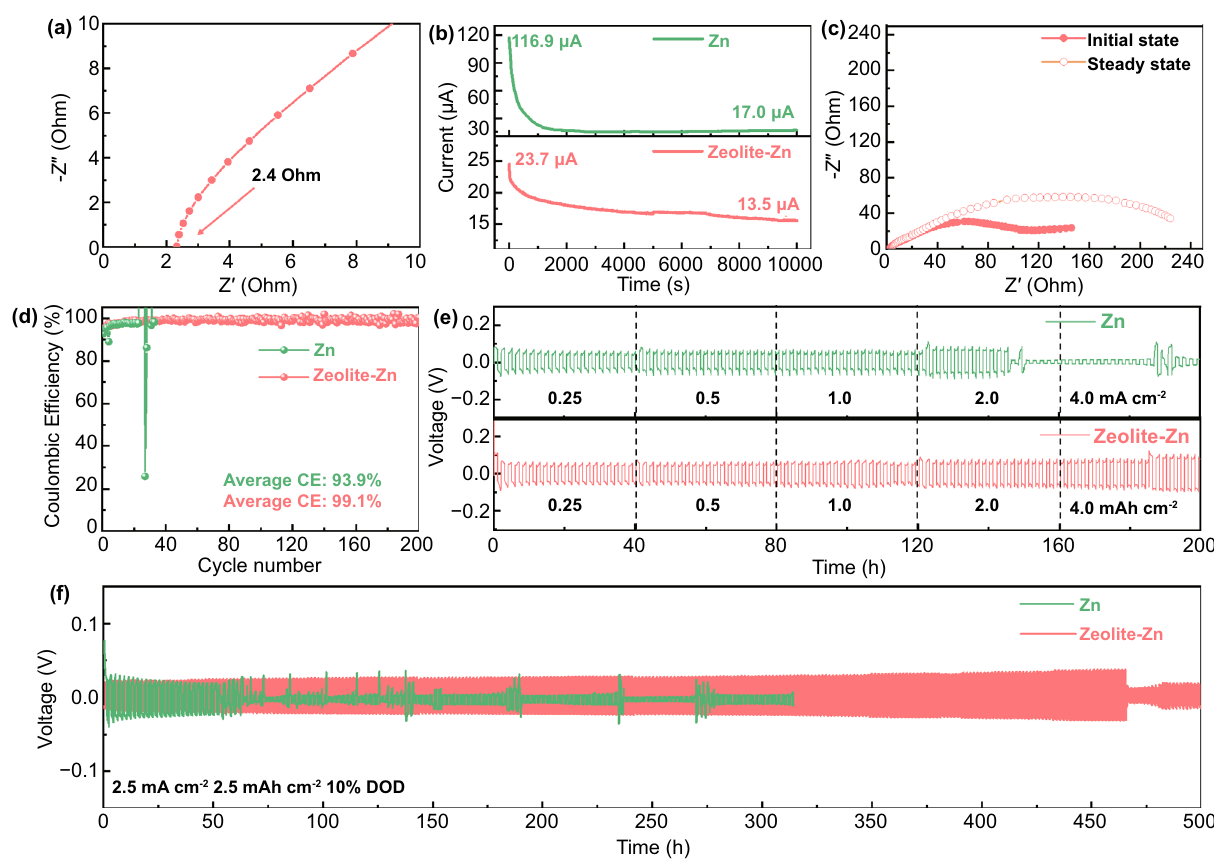
Fig. 2 a EIS plot of the zeolite layer. b Current–time (I-t) curves of a Zn||Zn and Zeolite-Zn||Zeolite-Zn symmetric cells stimulated by a con- stant polarization voltage of 10 mV. c EIS plot of the symmetric cells before (initial state) and after applying voltage polarization for 10,000 s (steady state). d Coulombic efficiencies (CEs) of a bare Zn||Cu and a Zeolite-Zn||Zeolite-Cu asymmetric cells in 1 M ZnSO 4 electrolyte; the employed current density is 0.5 mA cm −2 with a striping upper-limit voltage of 0.5 V. e–f Voltage profiles of Zn||Zn and Zeolite-Zn||Zeolite-Zn symmetric cells during galvanostatic cycling test in 1 M ZnSO 4